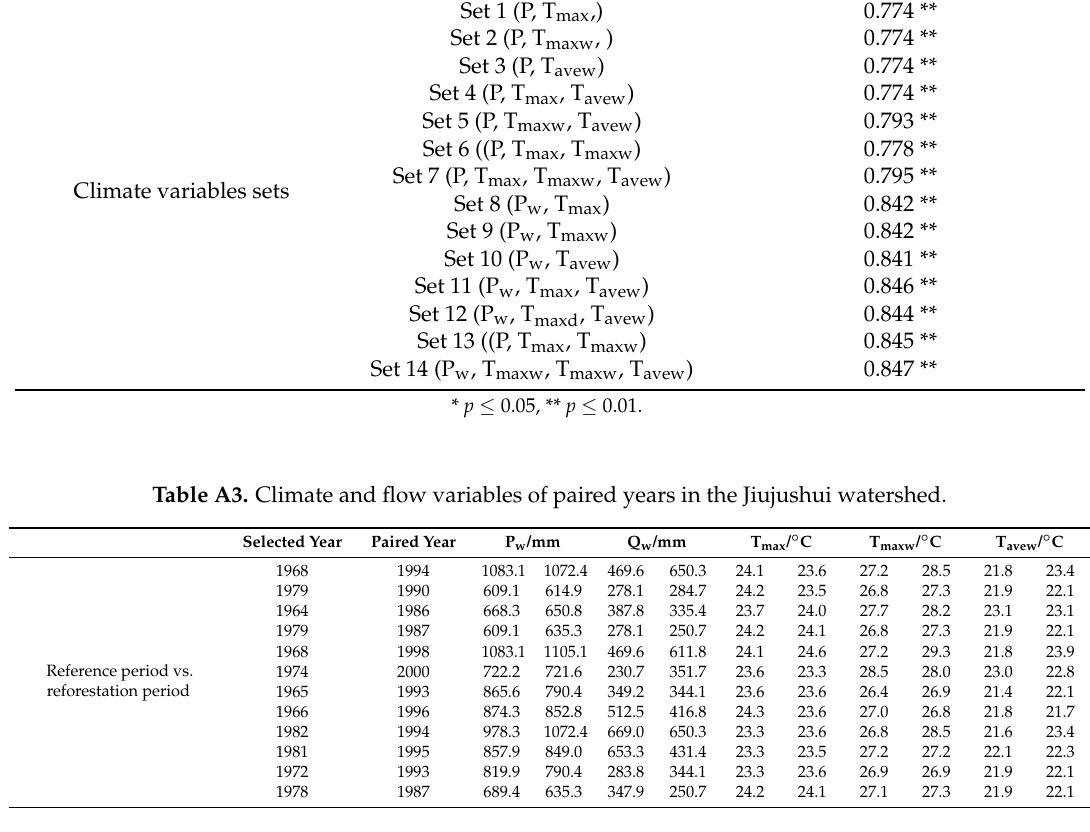
Table A2. Canonical correlation analysis between hydrological variables and climate factors. Canonical R